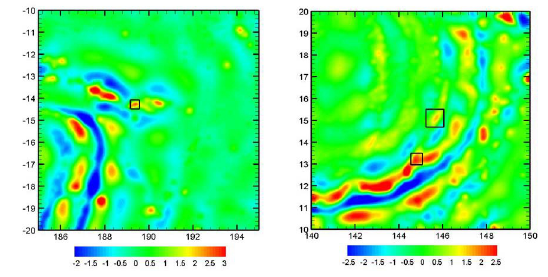
Figure 4. Omission error in terms of geoid height estimated from EGM2008 from degree and order 181 to 2190 in [m]. Left: American Samoa (see black box); Right: Guam (lower black box) and Northern Marianas (upper black box).